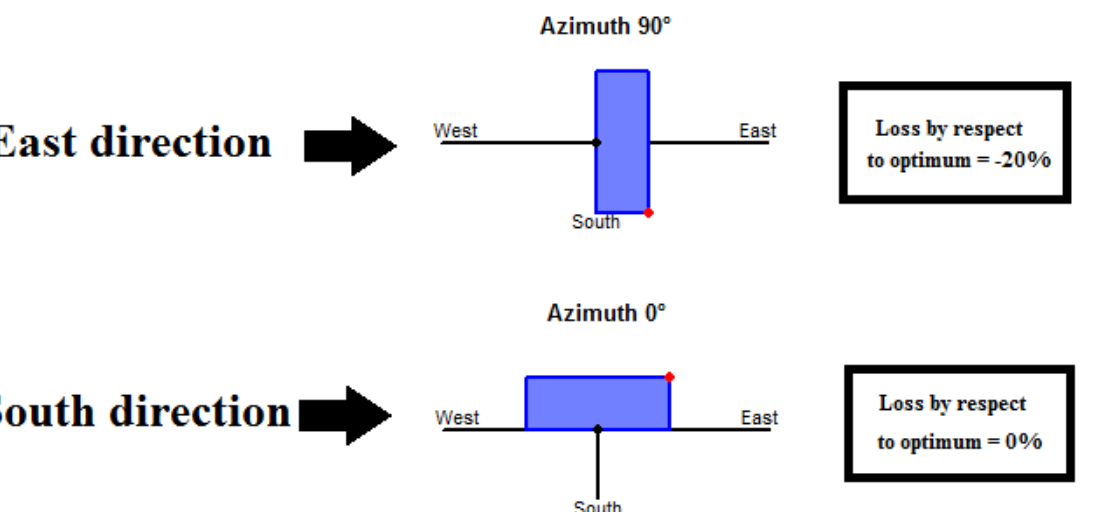
Figure 6. Simulation of the solar radiation loss with respect to the optimum in different directions.